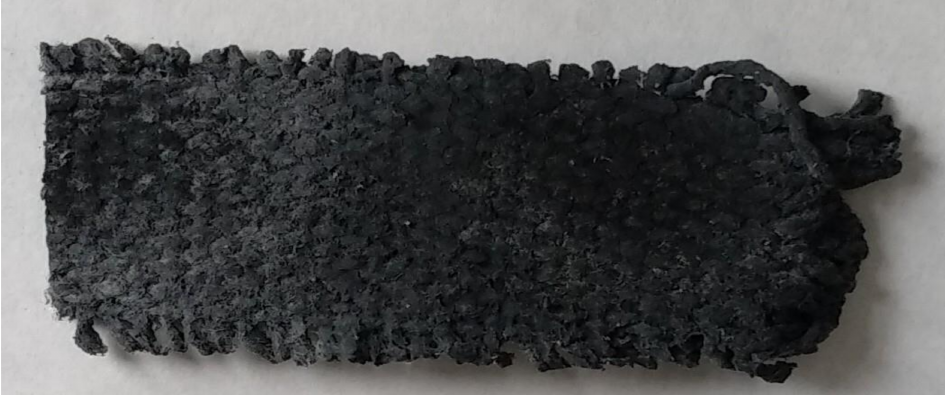
Figure 2. Conductor used in